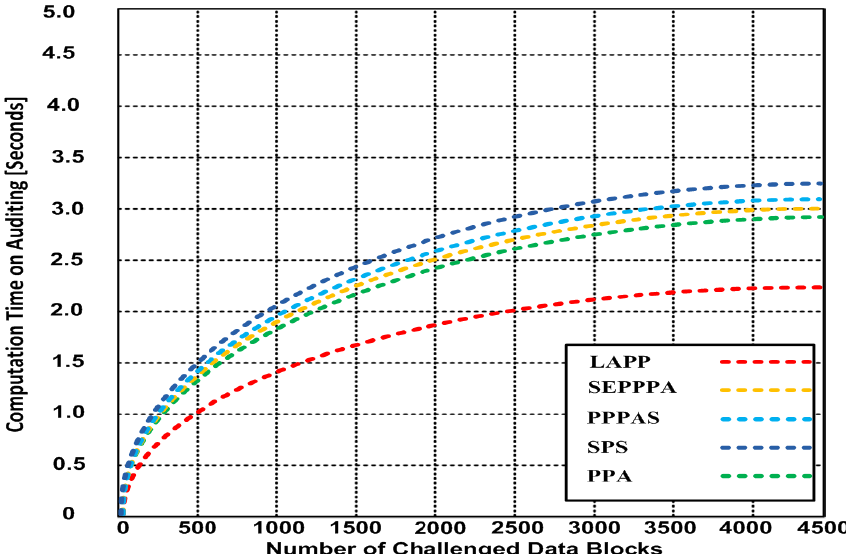
Figure 2. Computation time of auditing (number of challenged data blocks).